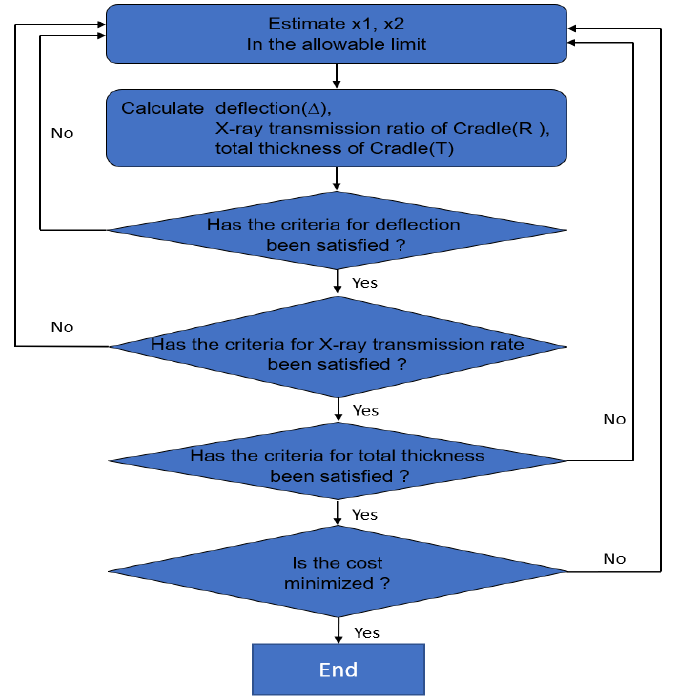
Figure 6. Optimization Algorithm for Sandwich Cradle.